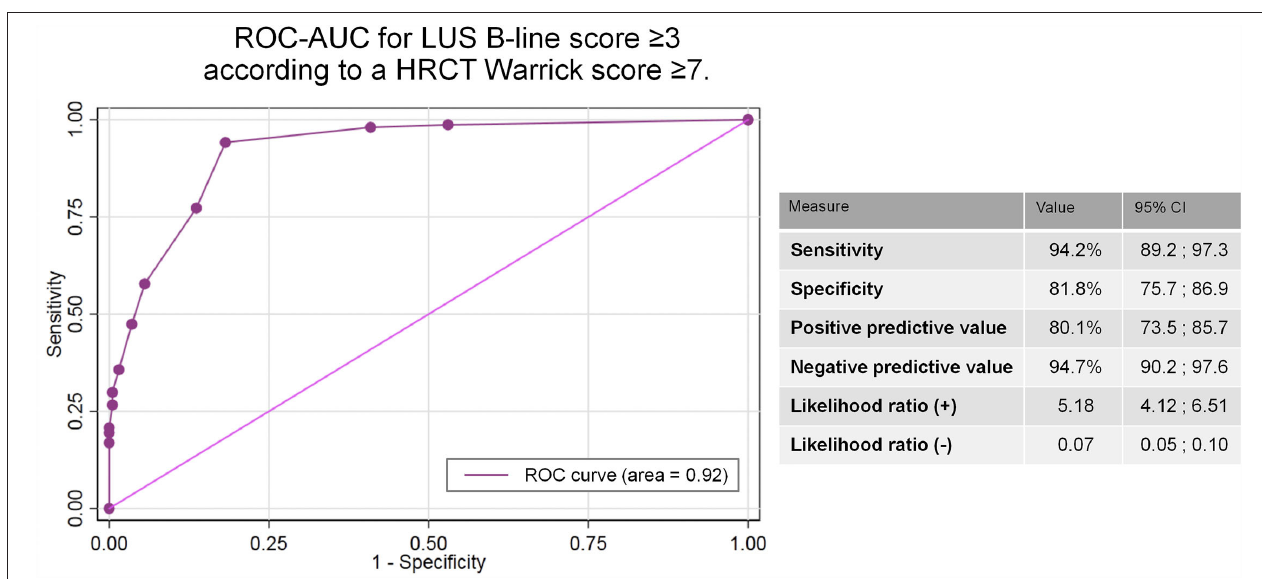
FIGURE 4 | AUC-ROC to determine the LUS B-line score ability to discriminate patients with relevant interstitial lung sequelae after COVID-19 according to a HRCT Warrick score ≥